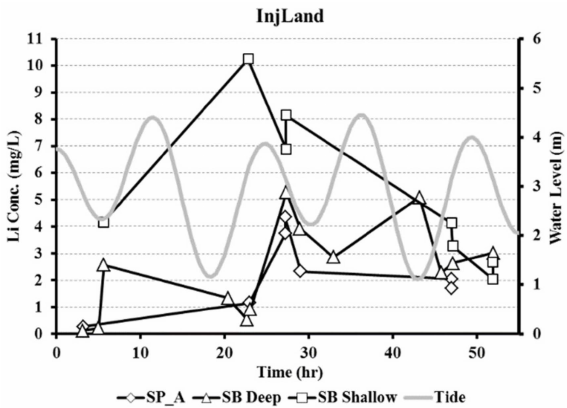
Figure 5. Variation of the concentration at various vertical locations at InjLand, which was 1.6 m landward of the injection well. The depth of each SP and SB is reported in Table